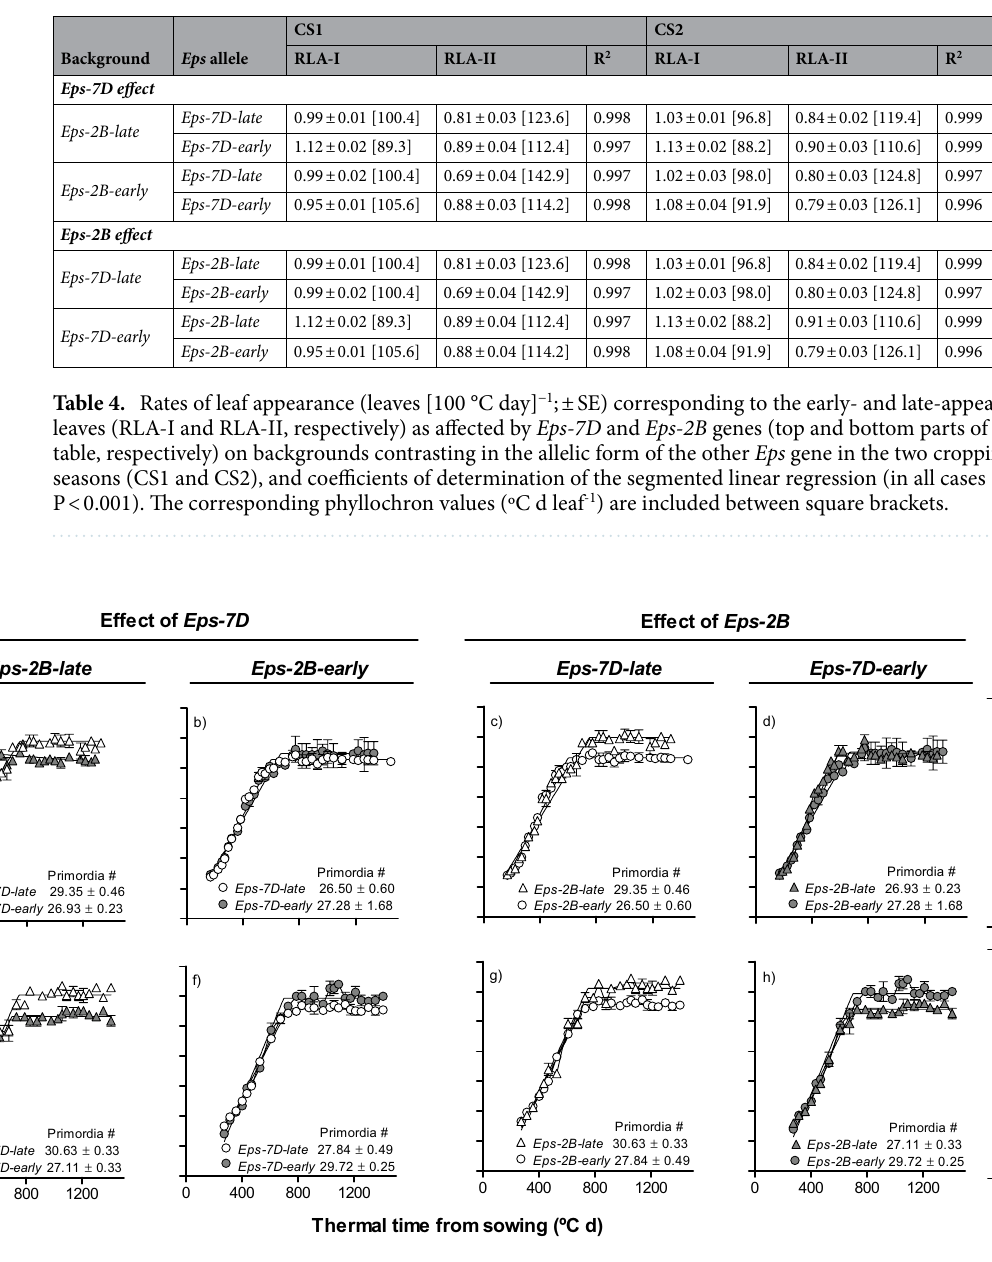
Figure 4. Relationship between number of primordia initiated on the main shoot apex and thermal time from sowing as affected by Eps-7D (left panels: a , b , e , f ) and Eps-2B genes (right panels: e , d , g , h ) on backgrounds contrasting in the allelic form of the other Eps gene (left and right panels within each Eps gene) in cropping seasons 1 (top panels: a – d ) and 2 (bottom panels: e – h ). Inside each of the panels are the total number of primordia with their